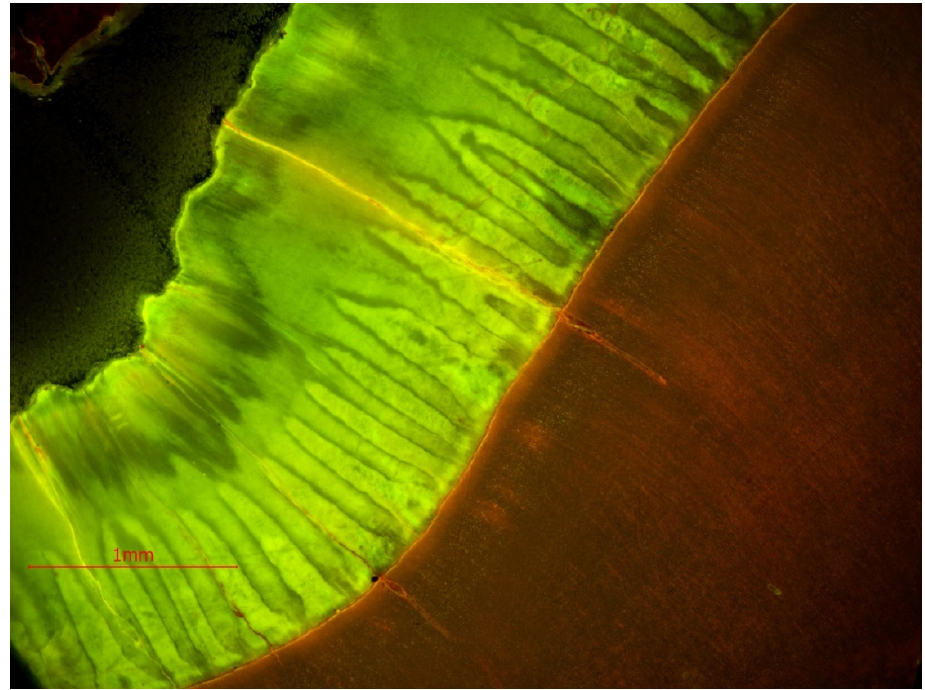
Figure 10. SEM micrograph of enamel (horizontal section through the crown) on the third premo- lar (P 3 ) of the white rhinoceros female. EHT: electron high tension voltage; WD: working distance between the sample surface and the low portion of the lens; Signal A = SE1: secondary electrons emitted from the top of the sample surface resulting from interaction with primary beam.